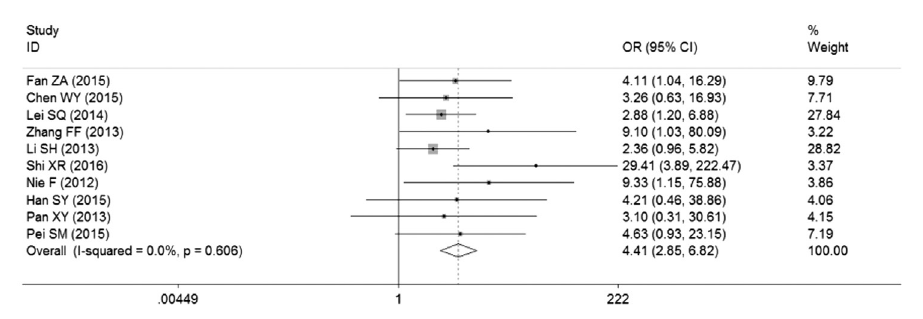
Figure 2. Forest plots of analysis of study group versus control group for clinical efficacy. The results are presented as individual and pooled ORs and 95% CIs. CI = confidence interval; OR = odds ratio.